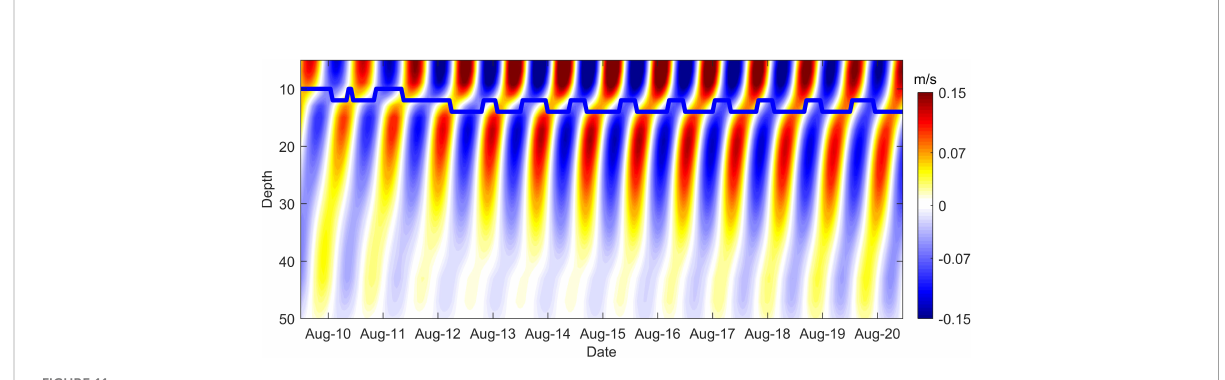
FIGURE 11 The simulated near-inertial velocity (m/s) at the mooring site in the absence of tide. The blue line denotes the depth of the maximum strati fi cation of the simulation.